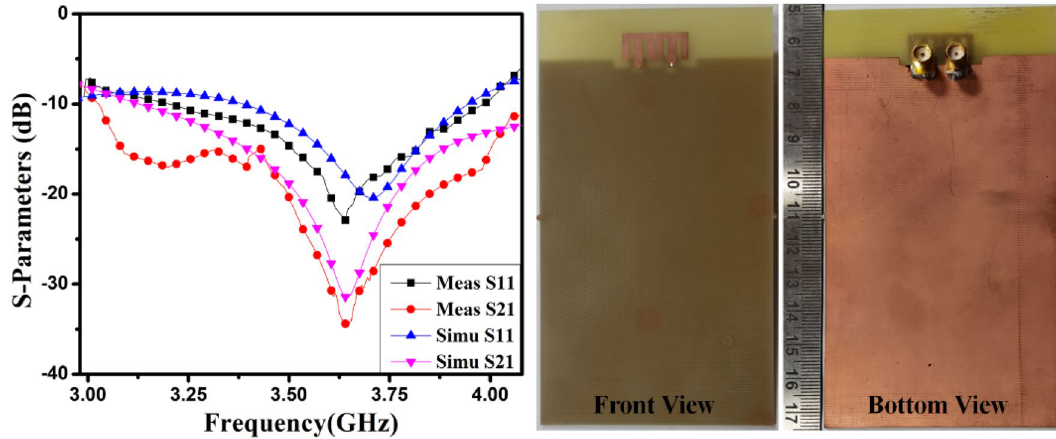
Figure 16. The proposed customized MIMO (M-shaped) antenna measured S-parameters (fabricated sample in enclosure).